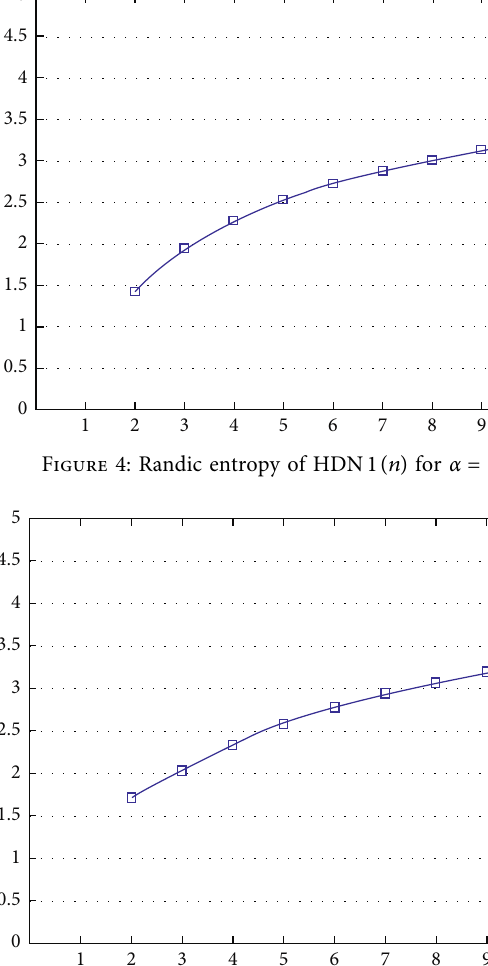
Figure 5: Randi´c entropy of HDN 1 ( n ) for α � ( 1/2 )